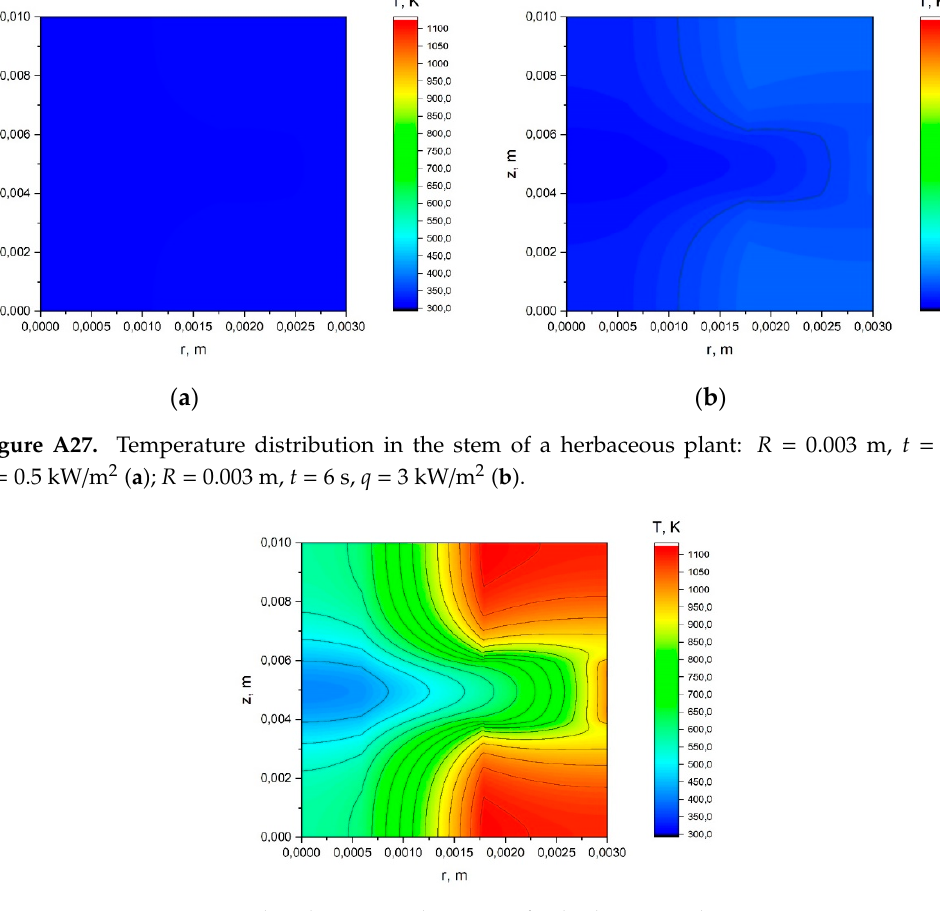
Figure A28. Temperature distribution in the stem of a herbaceous plant: R = 0.003 m, t = 6 s, q = 30 kW/m 2 .